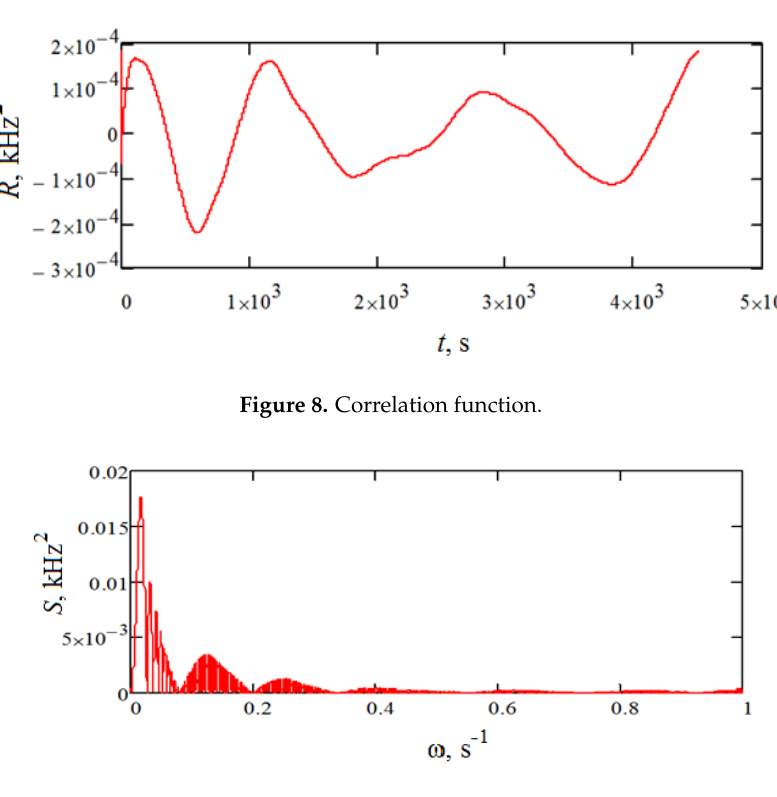
Figure 7. The noise component of the sample output signal.